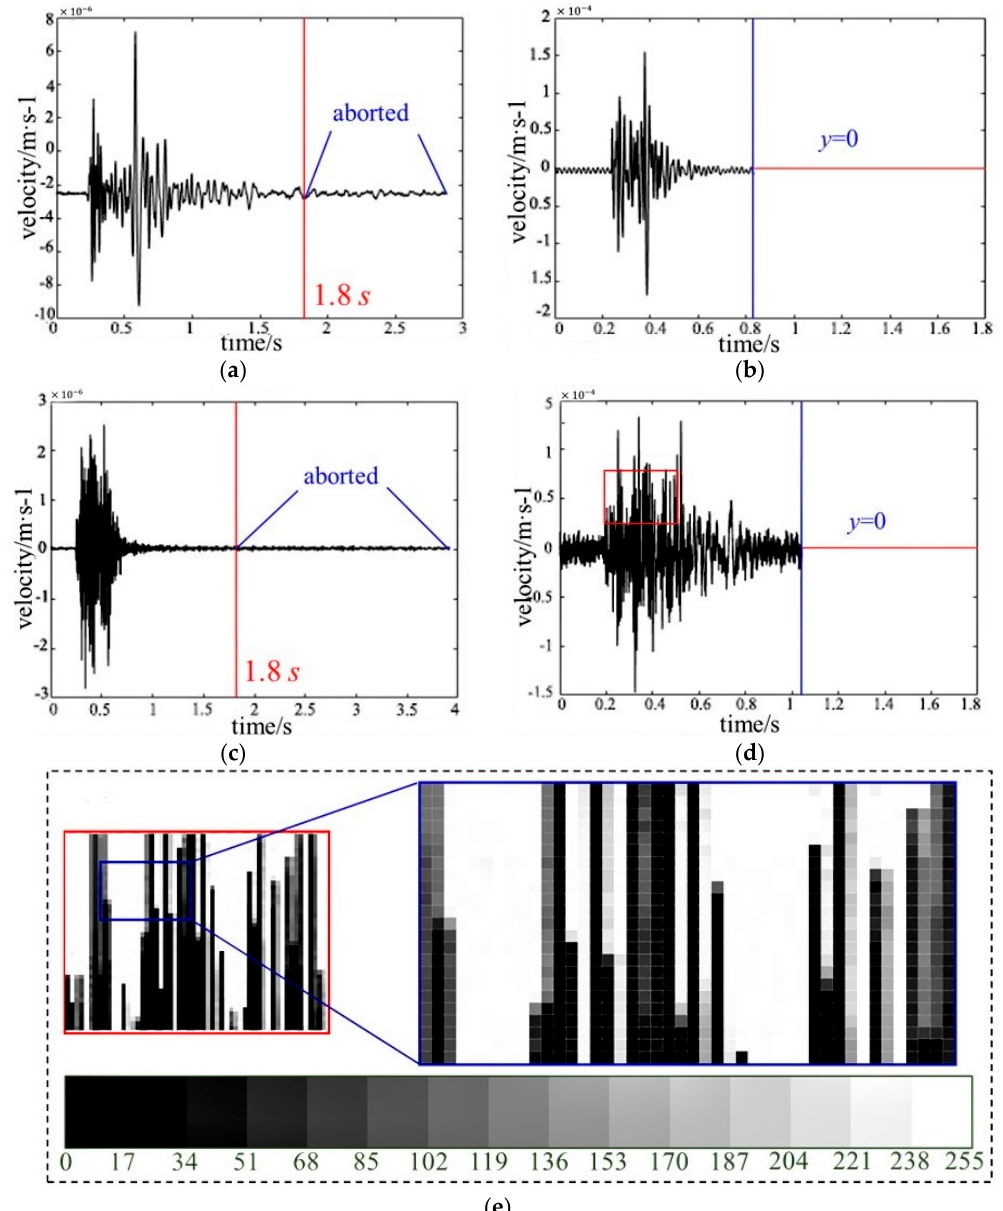
Figure 3. Examples of waveform images of micro-seismic events and blasts. ( a ) Waveform image of a micro-seismic event whose signal duration is greater than 1.8 s; ( b ) Waveform image of another micro-seismic event whose signal duration is less than 1.8 s; ( c ) Waveform image of a blast whose signal duration is greater than 1.8 s; ( d ) Waveform image of another blast whose signal duration is less than 1.8 s; ( e ) A part of pixels distributed in the red rectangle of ( d ), which are surrounded by the blue rectangle, and the corresponding gray values. The pure black and pure white correspond to the gray values of 0 and 255, respectively.